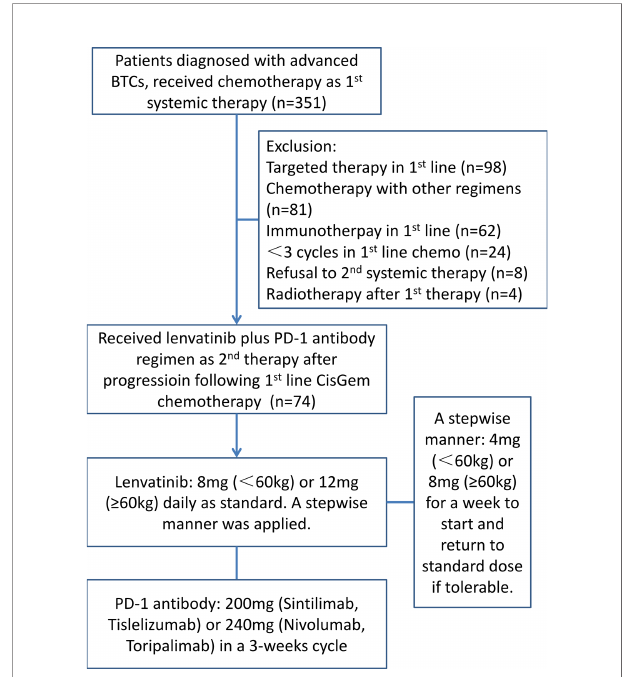
FIGURE 1 | The fl owchart of the study illustrates the enrollment procedure and the treatment